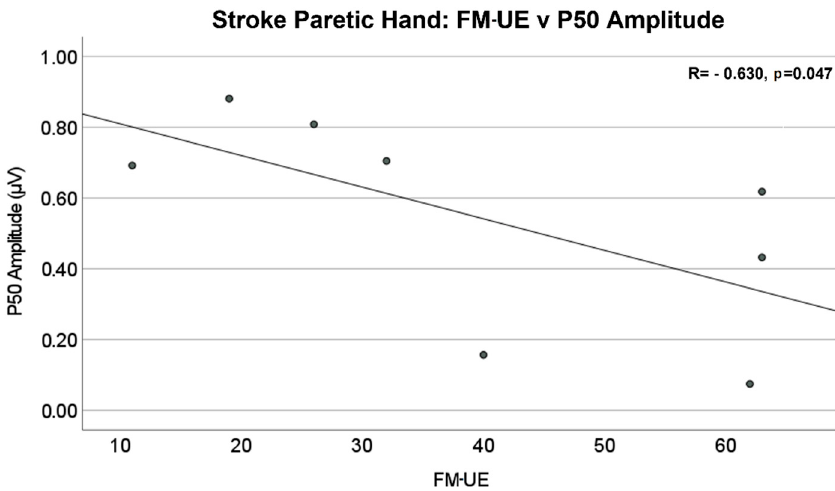
Figure 5. Latency of contralateral (to stimulated hand) Somatosensory Evoked Potential (SEP) com- ponent P50. Stars indicate a statistically significant difference between groups (control, stroke pa- retic hand (Stroke-P) and stroke non-paretic hand (Stroke-N)): *** < 0.001. The amplitude differences of P50 and N100 in the contralateral (to stimulated hand) hemisphere were not statistically significant between stroke and control groups. The mean values of amplitude are reported in Table 2. The Pearson correlation analysis showed that there was a significant negative linear relationship between the P50 amplitude of the contralateral (to stimulated hand) SEP responses and Fügl–Meyer upper extremity (FM-UE) score (R = − 0.630, p = 0.047), as shown in Figure 6. No significant correlations were found between FM-UE and other SEP measures.